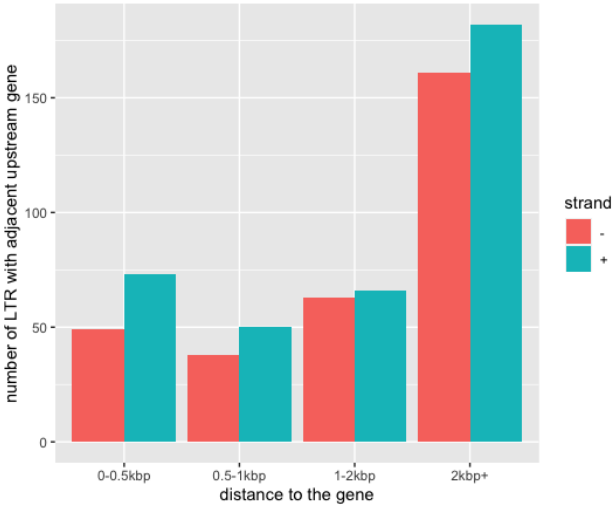
Figure 5. Number of sense LTR retransposons (strand+) and antisense LTR retransposons (strand-) with an adjacent upstream gene in Prunus mandshurica